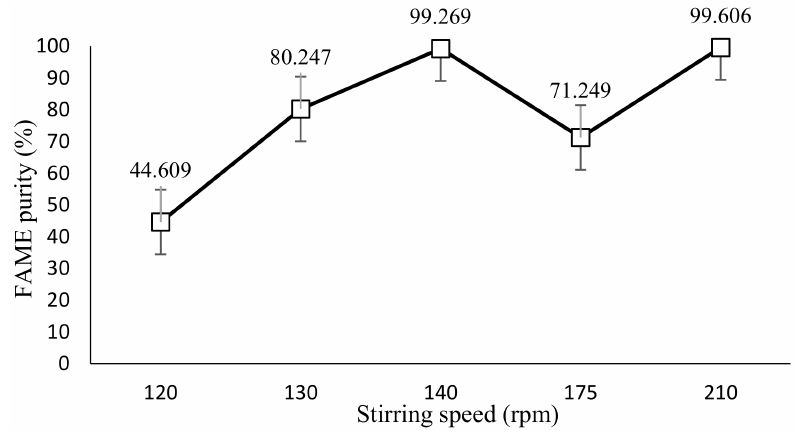
Figure 5. FAME purity against stirring speed. Table 3. Observation for the effect of stirring speed in